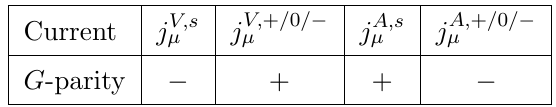
Table 6 . Properties of axial and vector currents under G